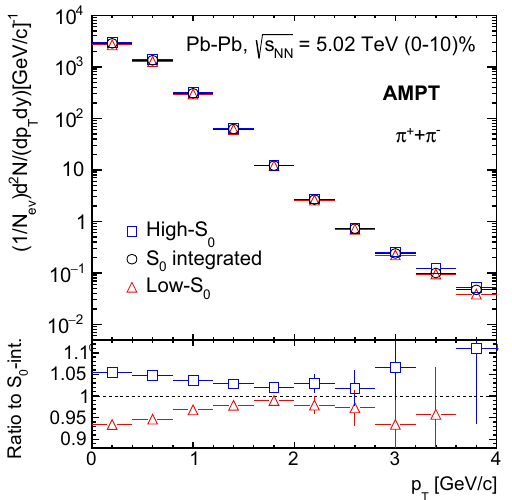
Fig. 2 Top plot: p T -spectra for pions in (0–10)% central Pb + Pb colli- sions for high- S 0 , S 0 -integrated and low- S 0 classes. Bottom plot: Ratio of p T -spectra for high- S 0 and low- S 0 events to the S 0 -integrated events medium is the correlation function between two particles in relative pseudorapidity ( (cid:7)η = η a − η b ) and azimuthal angle ( (cid:7)φ = φ a − φ b ). The labels a and b denote the two parti- cles in the pair, which are chosen from different (or same) transverse momentum intervals. In this study, we have taken